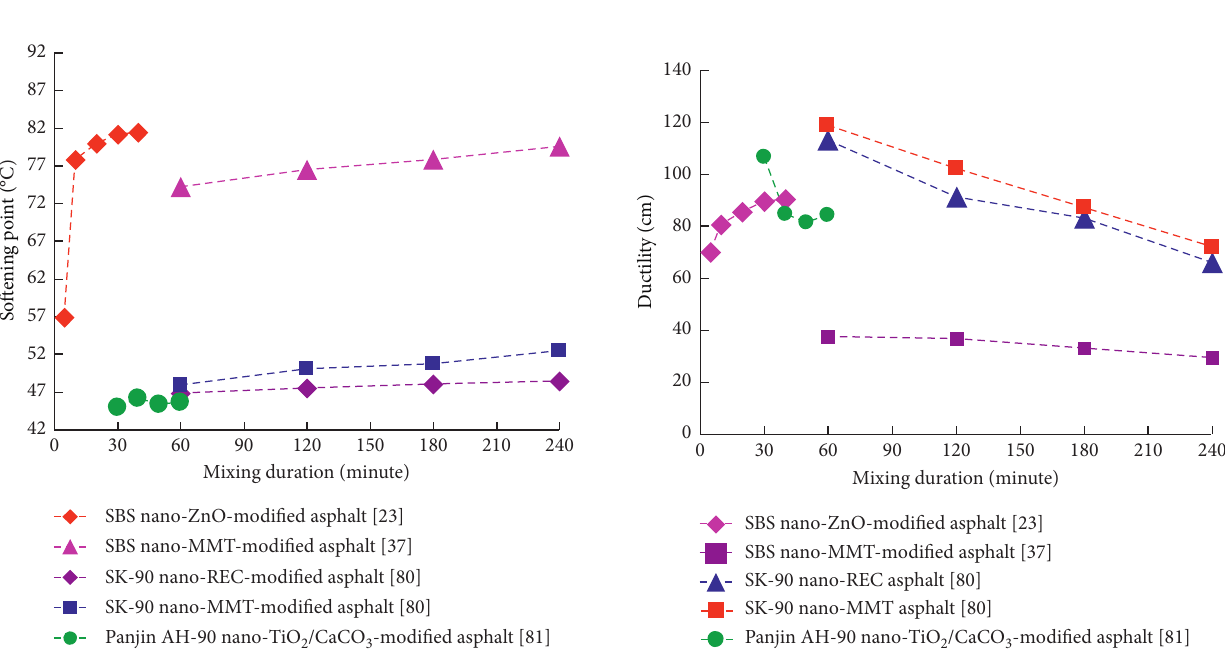
Figure 18: Mixing duration effect on